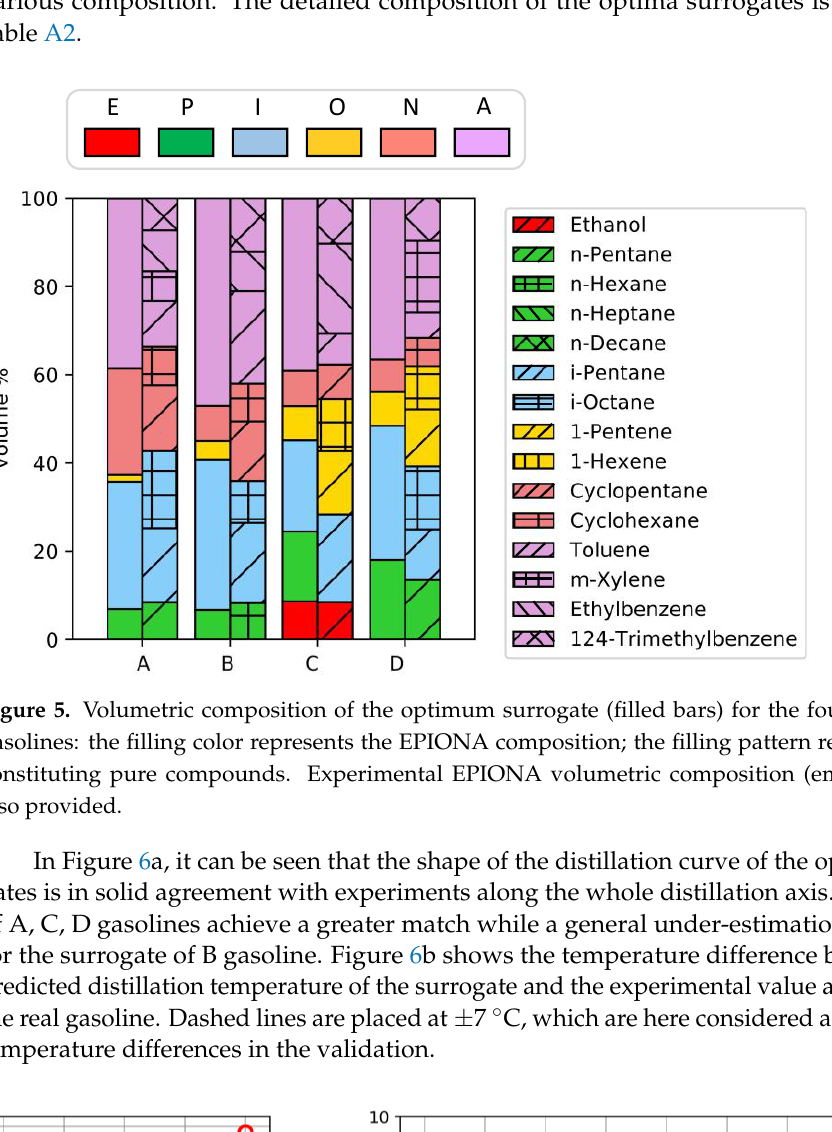
Figure 5. Volumetric composition of the optimum surrogate (filled bars) for the four validation gas- olines: the filling color represents the EPIONA composition; the filling pattern represents the con- stituting pure compounds. Experimental EPIONA volumetric composition (empty bars) is also pro- vided.